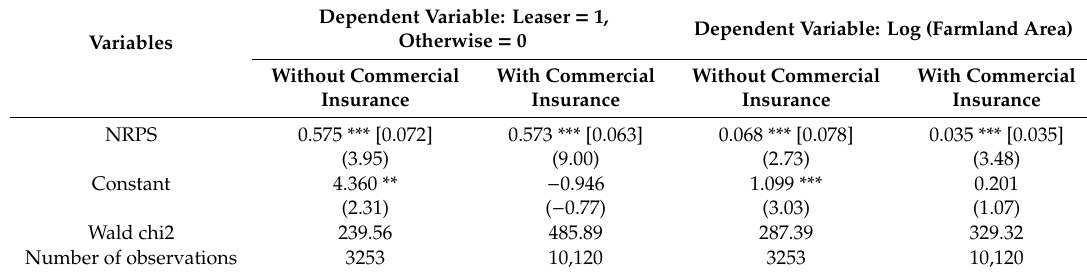
Table 10. Heterogeneity test for participating in commercial pension insurance.